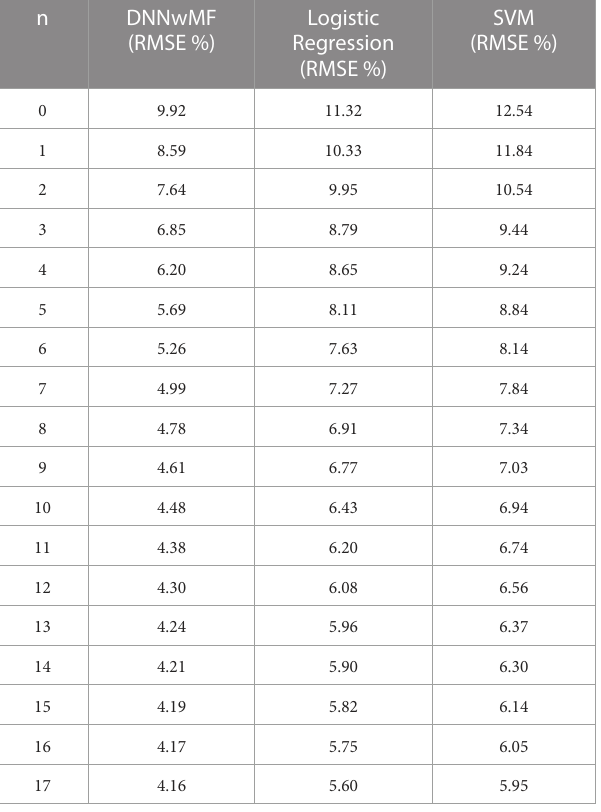
TABLE4 ComparisonofDNNwMFwithlogisticregressionandSVMonNASA dataset.